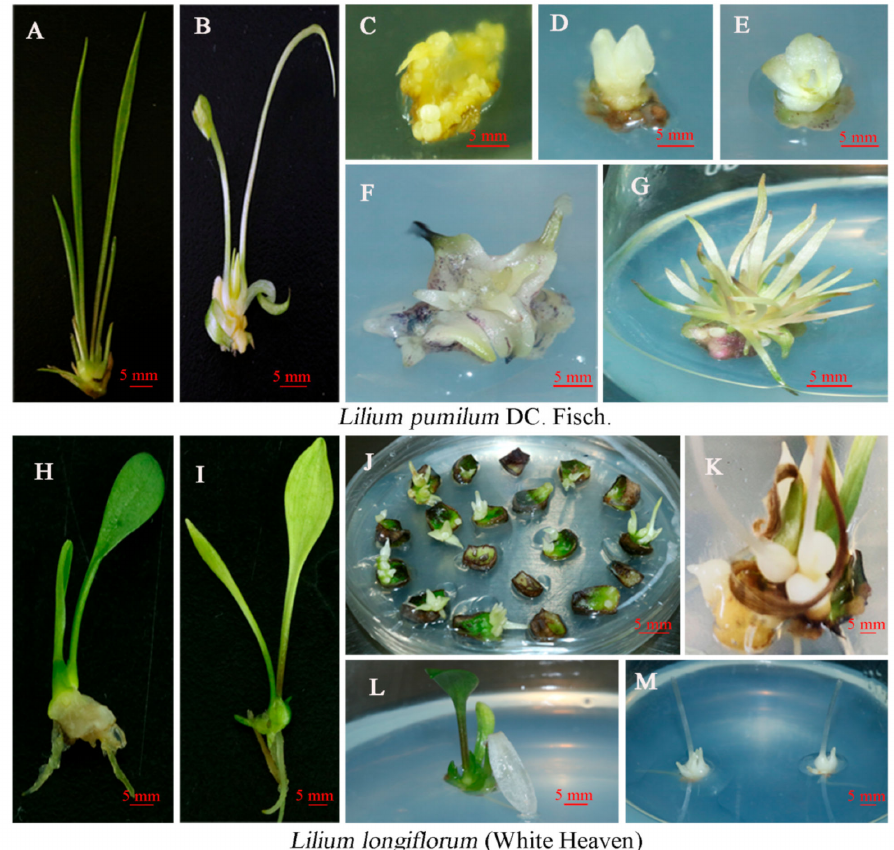
Figure 5. Phenotypes of LpPDS mutants after transformation with the CRISPR / Cas9 system. A–G show Lilium pumilum DC. Fisch. A Nontransgenic plant. B Yellowing mutant. C Resistant somatic embryos. D Mature embryo. E – F Dwarf mutants. G Completely albino plants. H – L show ‘White Heaven’. H Nontransgenic plant. I Yellowing mutant. J Resistant buds. K and L Mixed green and white leaves. M Completely albino plants (bars = 5